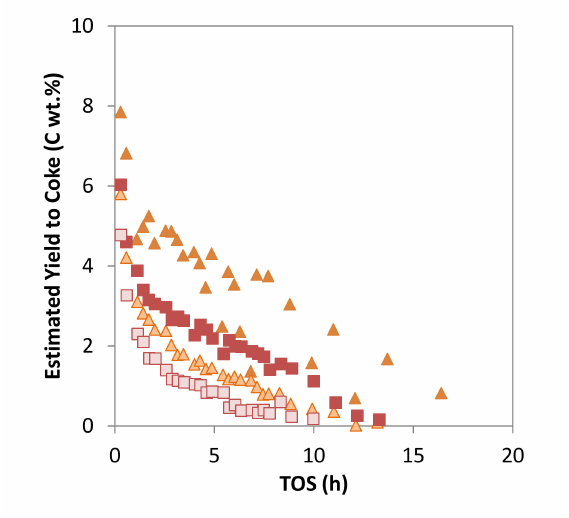
Figure 7. Estimated yield to coke versus time on stream (TOS) for the catalysts: MoZ5-SSR-DC ( ), MoZ5-SSR-SC-N 2 ( ), MoZ5-SSR-DC ( ) and MoZ5-SSR-DC-N 2 ( ), at 973 K and atmospheric pressure (w/F = 16 g ·